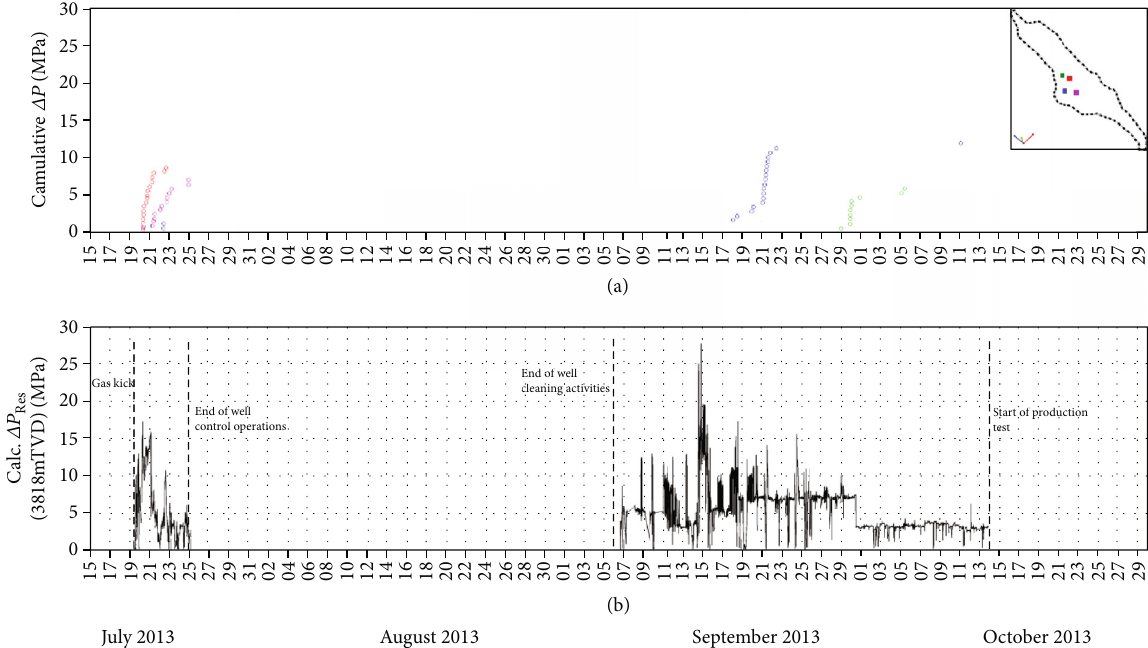
Figure 9: (a) Temporal evolution of cumulative fl uid pressure changes determined from repeated slips at the 4 locations in the reservoir indicated by corresponding colours in the small fi gure inset. A constant stress drop of 0.5MPa is assumed. Contour line in the fi gure inset denotes the main region of seismic activity. (b) Temporal evolution of the calculated pressure changes Δ P Res : in the wellbore at a depth of 3,818m (open-hole section) during well control operations in July 2013 and well cleaning activities in September/October 2013.